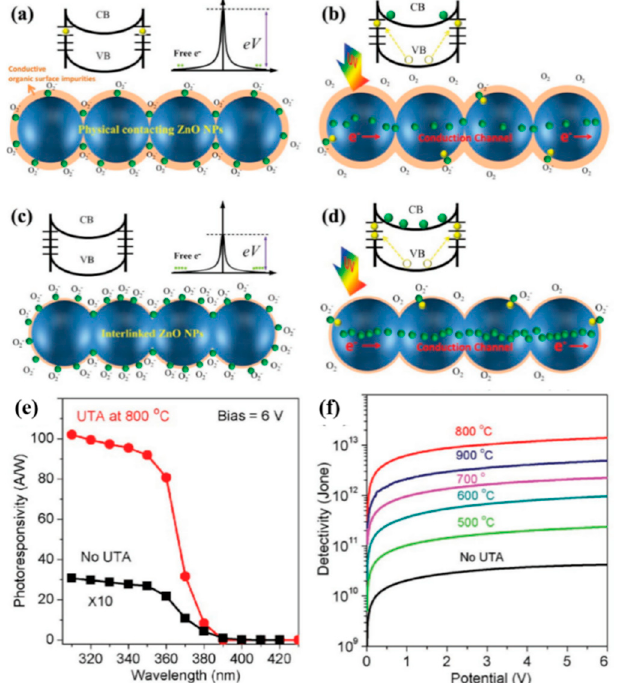
Figure 10. ( a , b ) The ZnO-NP before ultrafast thermal annealing (UTA). Schematic diagram of the energy band (top) and the photoresponse mechanism (bottom). ( c , d ) the nanojunction-interlinked ZnO-NP networks after the UTA treatment. The orange shell on ZnO-NPs represents the surface defects and contaminants. Green and yellow dots denote electrons and holes, respectively. ( e ) Spectral responsivity of the same PDs before and after UTA treatment at 800 °C for 2 s under the 340 nm UV illumination. ( f ) The relationship between applied bias and detectivity for a set of samples treated with UTA at different temperatures ranging from 500 to 900 °C [109].